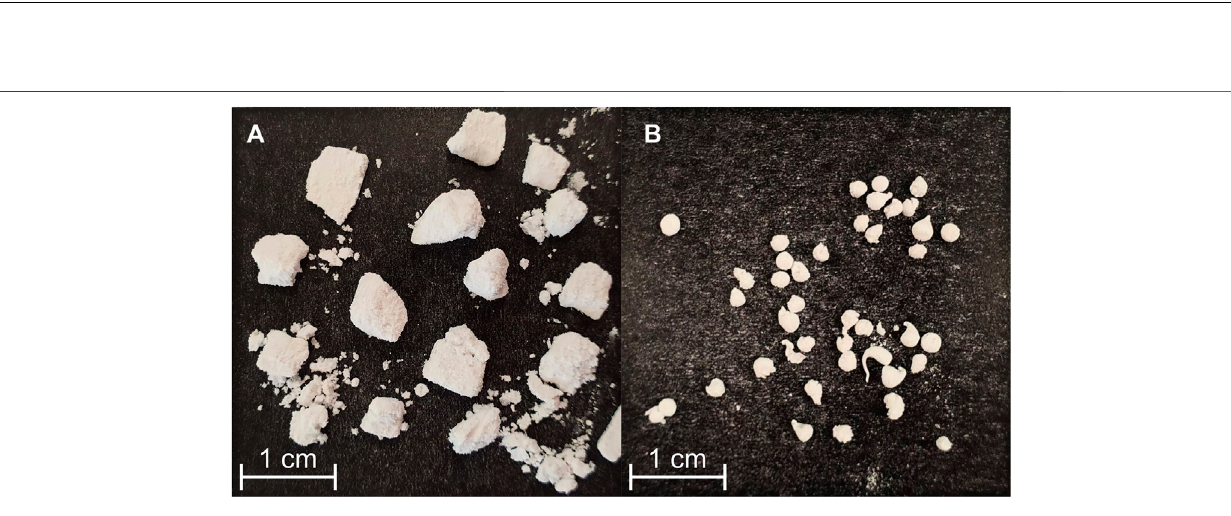
FIGURE 2 | (A) Agglomerates, (B)